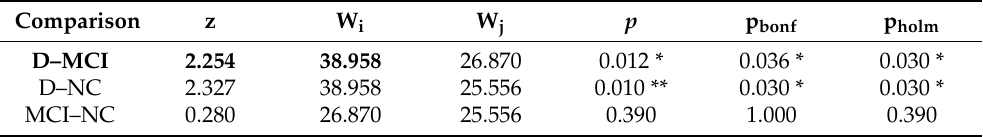
Table 4. Dunn post-Hoc comparison of Centrum semiovale PVS between D–MCI, D–NC, and MCI–NC groups.